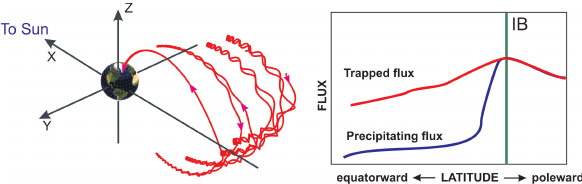
Fig. 16. Illustrating the IB concept. Left: a 3-D view of a numerically traced particle orbit, crossing the equatorial current sheet out- side of IB. After several bounces, the particle ends up in the iono- sphere due to the non-adiabatic scattering of its magnetic moment into the loss cone. Right: trapped (red) and precipitating (blue) par- ticle flux variation as seen by a low-altitude polar-orbiting satellite; poleward from the IB (green) both fluxes become